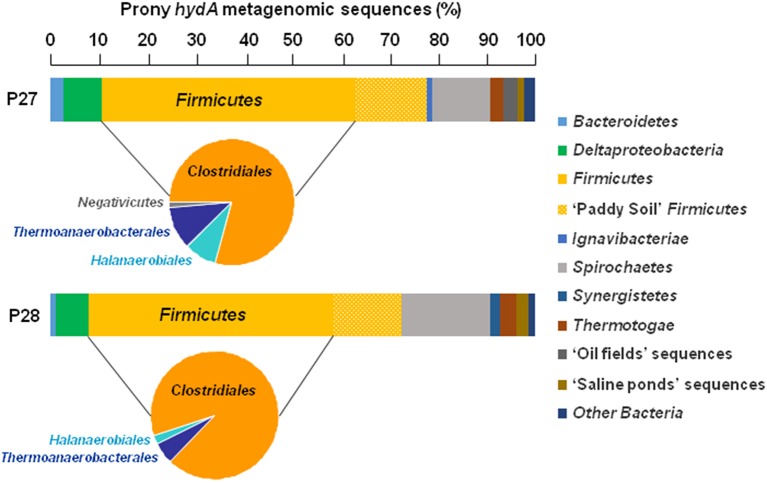
Distribution and taxonomic assignments of putative hydA gene sequences encoding the catalytic subunit of [Fe-Fe] hydrogenases in Prony Hydrothermal Field metagenomes. The histogram shows the relative abundance of major hydA phyla in the total hydA metagenomic sequences (n = 1678) and pie charts show distributions of “Firmicutes HydA” classes in the metagenomes P27 and P28 obtained from ST09 site.